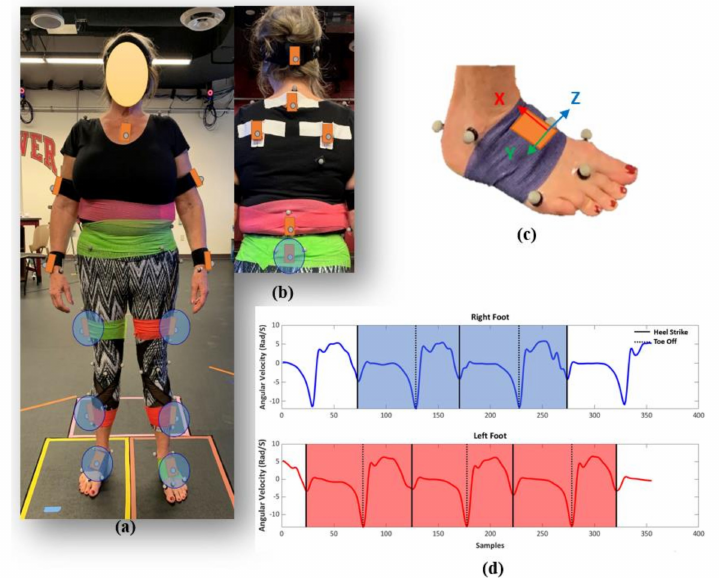
Figure 1. Subject suited up with markers and inertial measurement units (IMUs) ( a ) front, and ( b ) back view. IMUs circled in blue (feet, shanks, thighs, pelvis) were used in the supervised machine learning models. ( c ) IMU sensor attached on right foot with coordinate system, ( d ) a sample of segmented IMU data based on angular velocities of feet